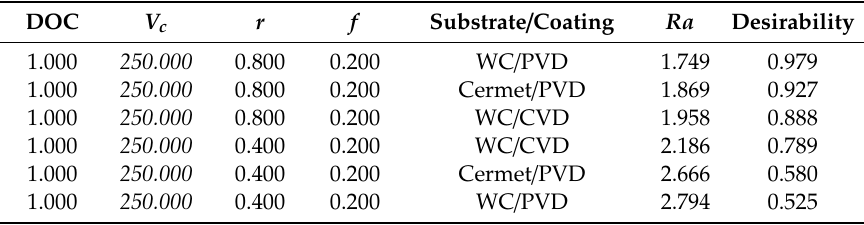
Table 13. Solutions of the Ra response optimization.